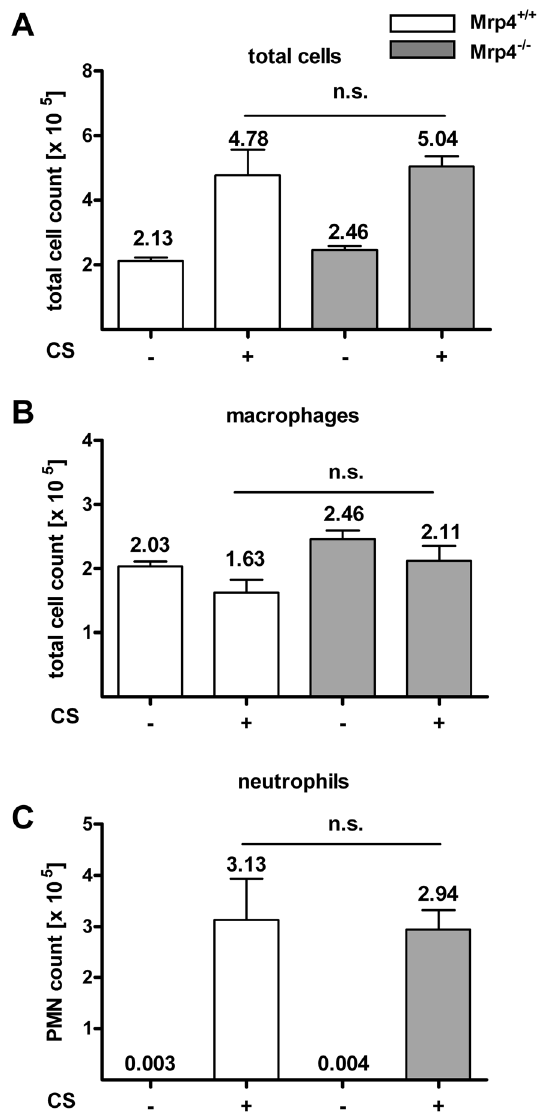
Figure 3. Neutrophils or macrophage concentrations were similar in BALF of Mrp4 2 / 2 and Mrp4 + / + mice exposed to cigarette smoke for 4 days. A) Total cell numbers, B) macrophage numbers and C) neutrophil numbers in the BALF were measured in Mrp4 + / + (white bars) and Mrp4 2 / 2 (grey bars) mice 4 days after exposure to cigarette smoke (CS, + ) or fresh air as control ( 2 ). n=8. n.s.=not significant. Data are mean 6 SEM.